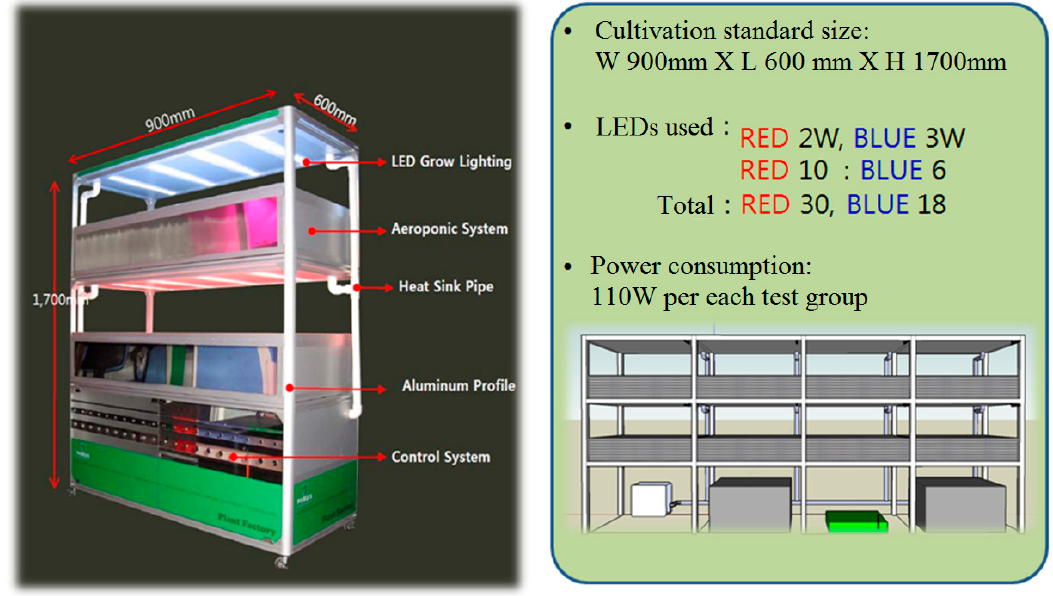
Figure 15. The design of cultivation test group for environmental control and monitoring.